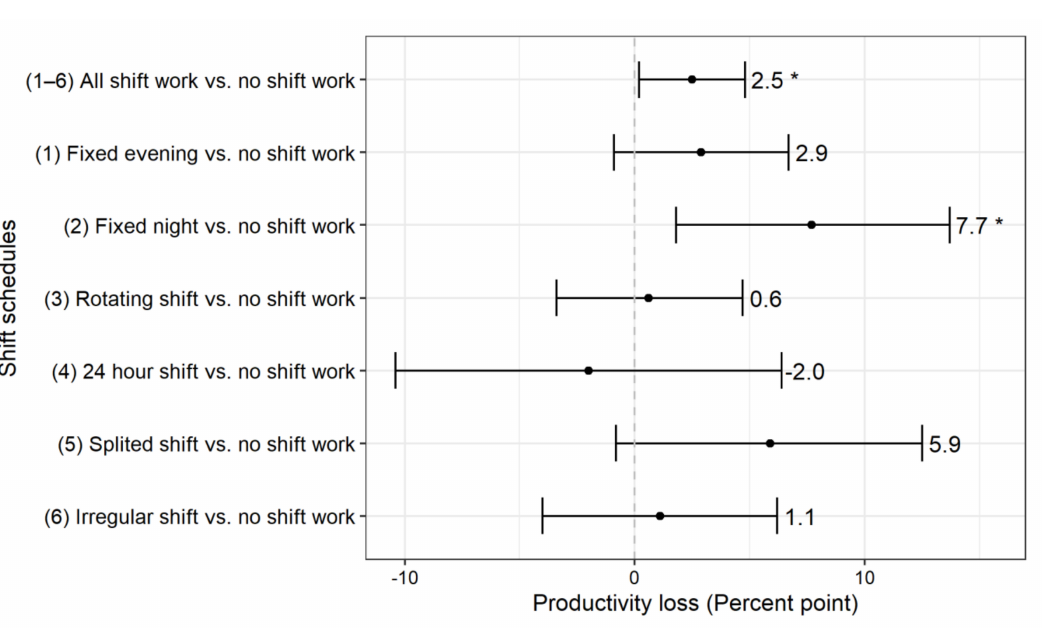
Figure 1. Adjusted di ff erences in work productivity impairment according to shift work schedules; * p -value <